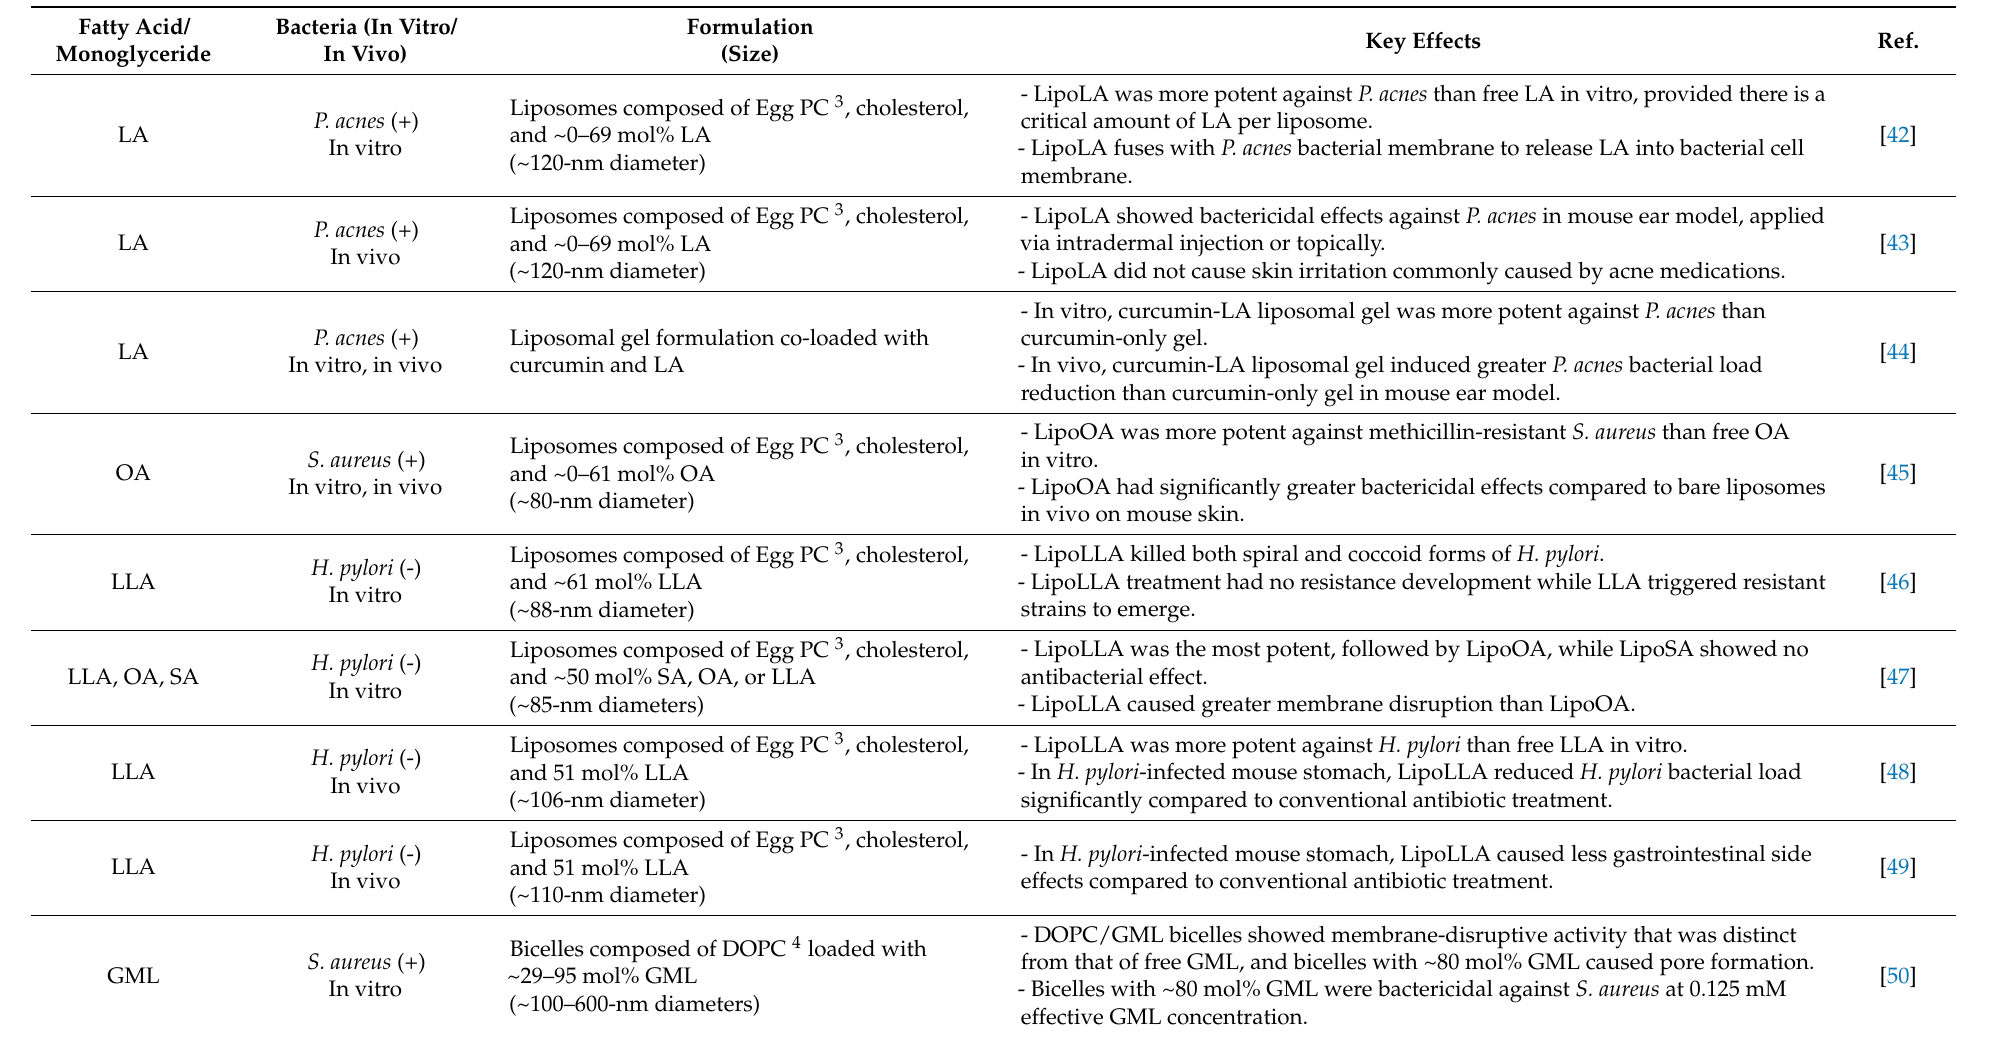
Table 1. Summary of antibacterial application examples utilizing lipid nanoparticles that incorporate biologically active fatty acids and monoglycerides 1,2 . Fatty Acid/